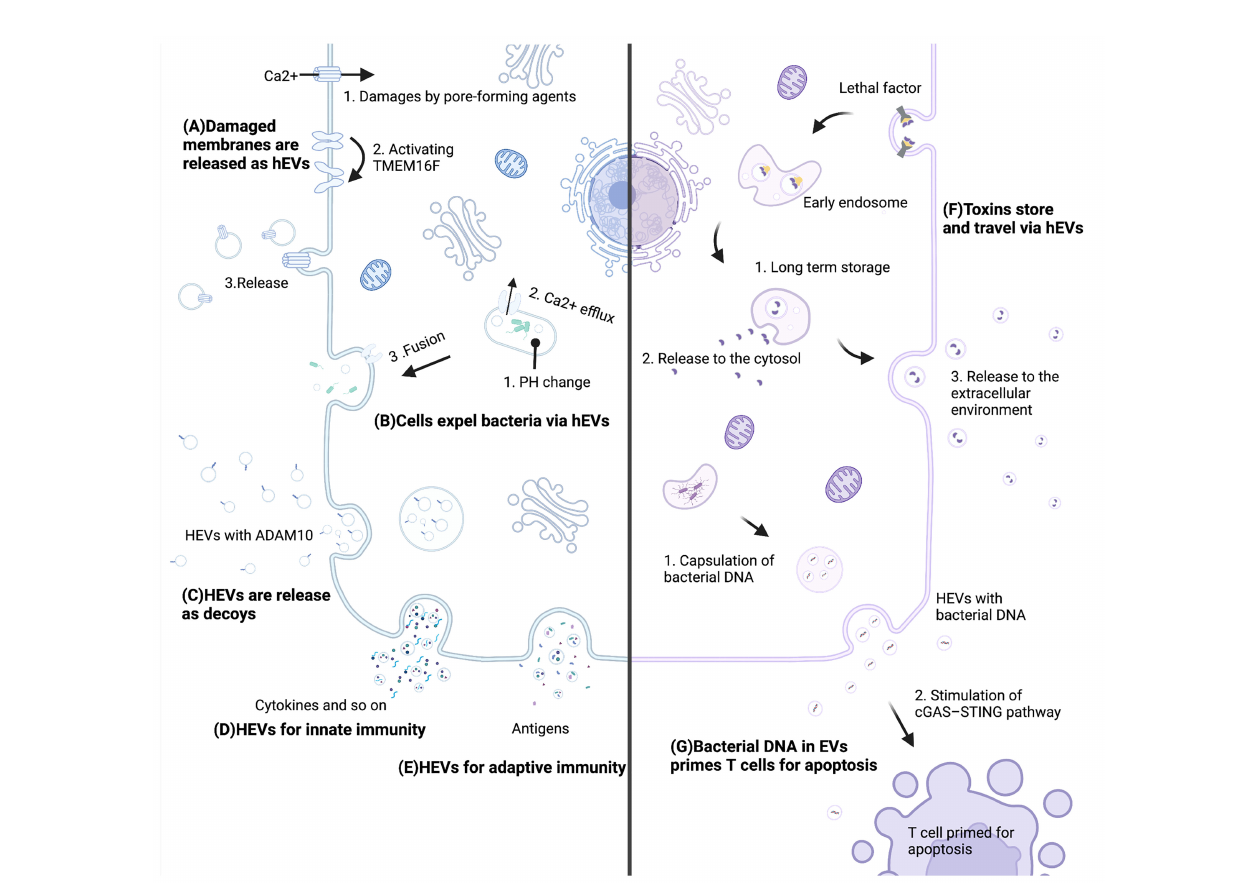
FIGURE 1 | Mechanisms of hEVs in the interaction between the host and bacteria. (A) Pore-forming agents lead to Ca2+ in fl ux and activate TMEM16F. Subsequently, damaged membranes are repaired by releasing hEVs. (B) A pH change leads to Ca2+ ef fl ux, and this ef fl ux triggers hEVs release to expel bacteria. (C) Host cells release ADAM10-containing hEVs to neutralize toxins. (D) Cells release molecules such as cytokines via hEVs for innate immunity. (E) Cells present antigens via hEVs for adaptive immunity. (F) Lethal factors of anthrax store in late endosomes sheltering from degradation and are released to the cytosol and the extracellular environment. (G) Bacterial DNA of Listeria monocytogenes is encapsulated into hEVs, and these hEVs stimulate the cGAS-STING pathway of T cells, which primes T cells for apoptosis. This fi gure was created with